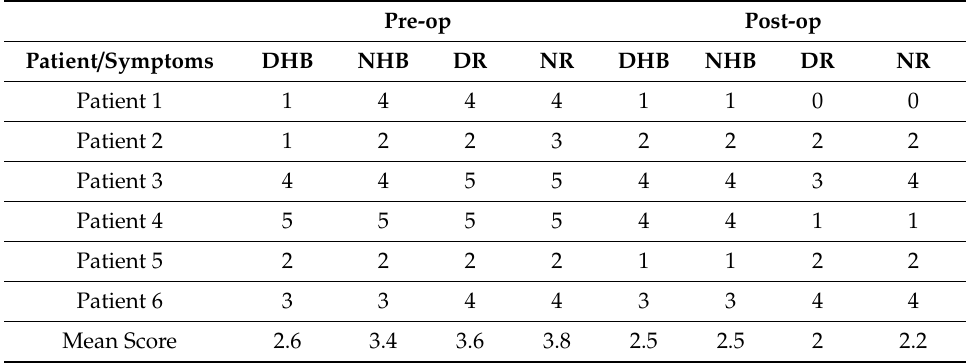
Table 1. Baseline and post-operative symptoms of patients with gastroparesis and GERD, showing significant improvement in nocturnal regurgitation post-operatively. DHB: day time heartburn, NHB: nocturnal heartburn, DR: day time regurgitation, NR: nocturnal